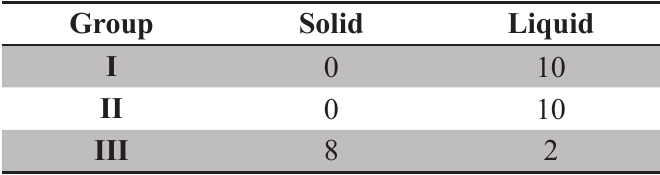
TABLE 4 - Aspect of